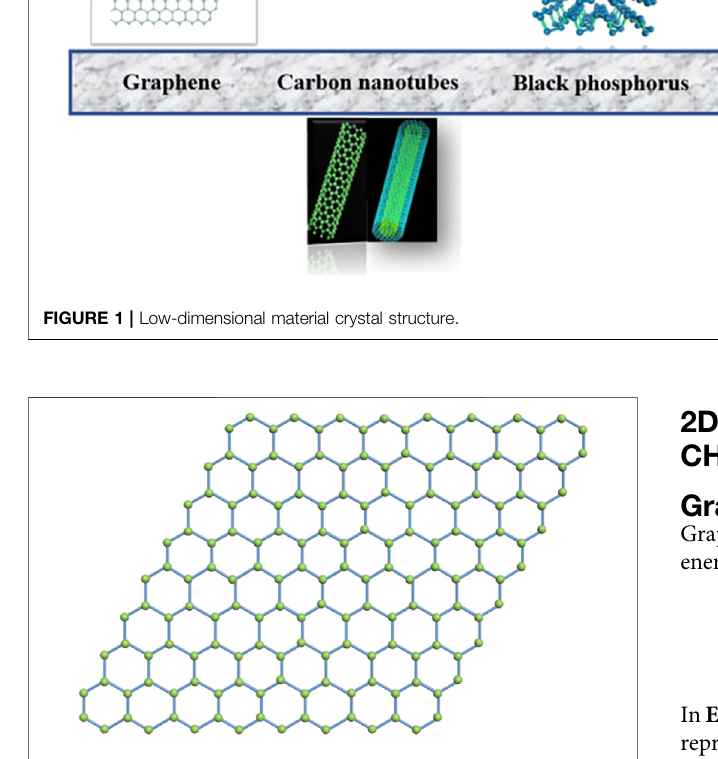
FIGURE 2 | Crystal structure of